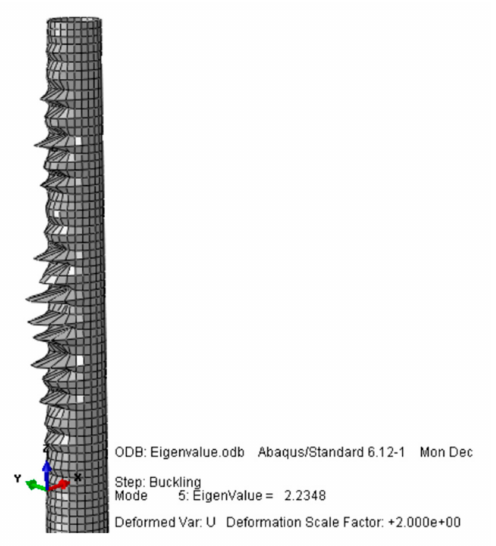
Figure 5. Tower_T_A 3rd Eigenmode.